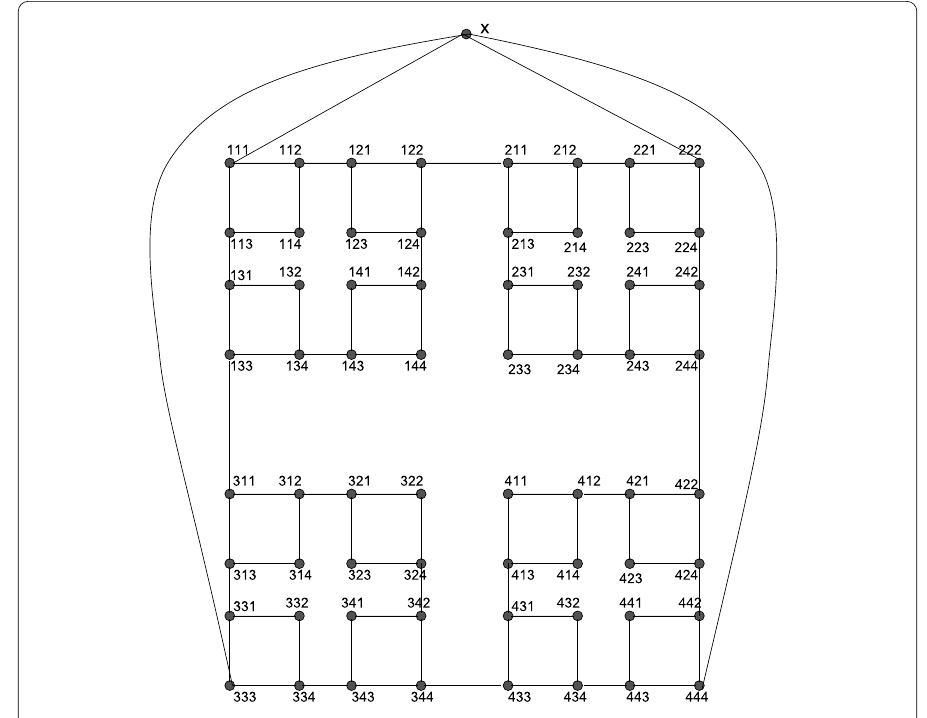
Figure 2 Extended Sierpi´nski graph